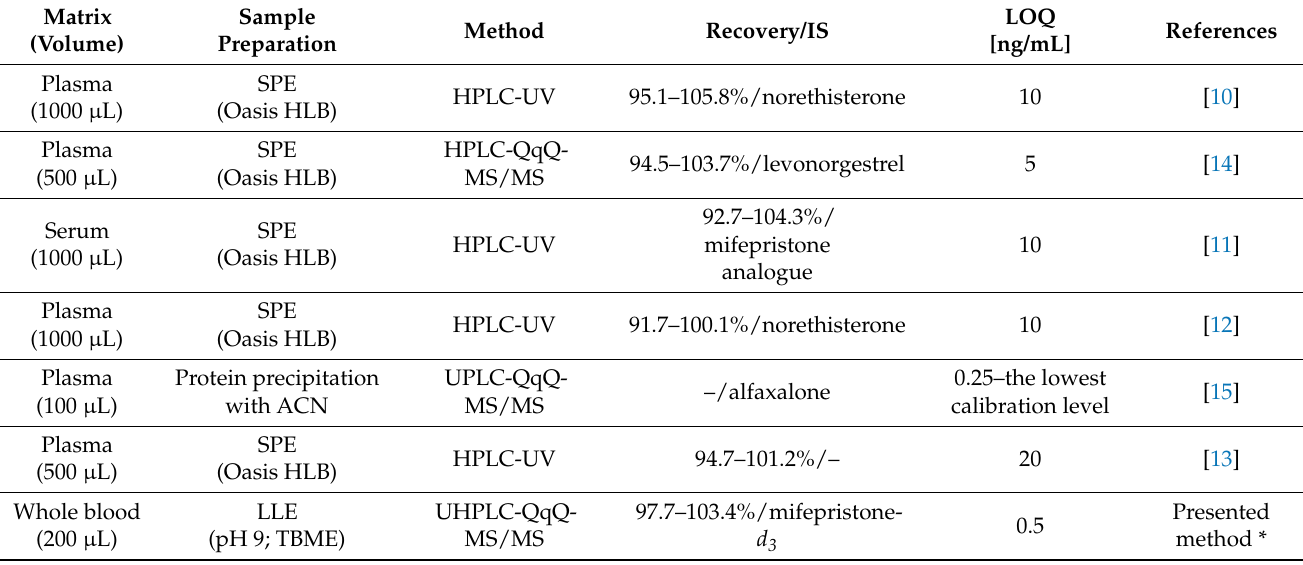
Table 4. Comparison of liquid-chromatographic methods applied for mifepristone determination in biological